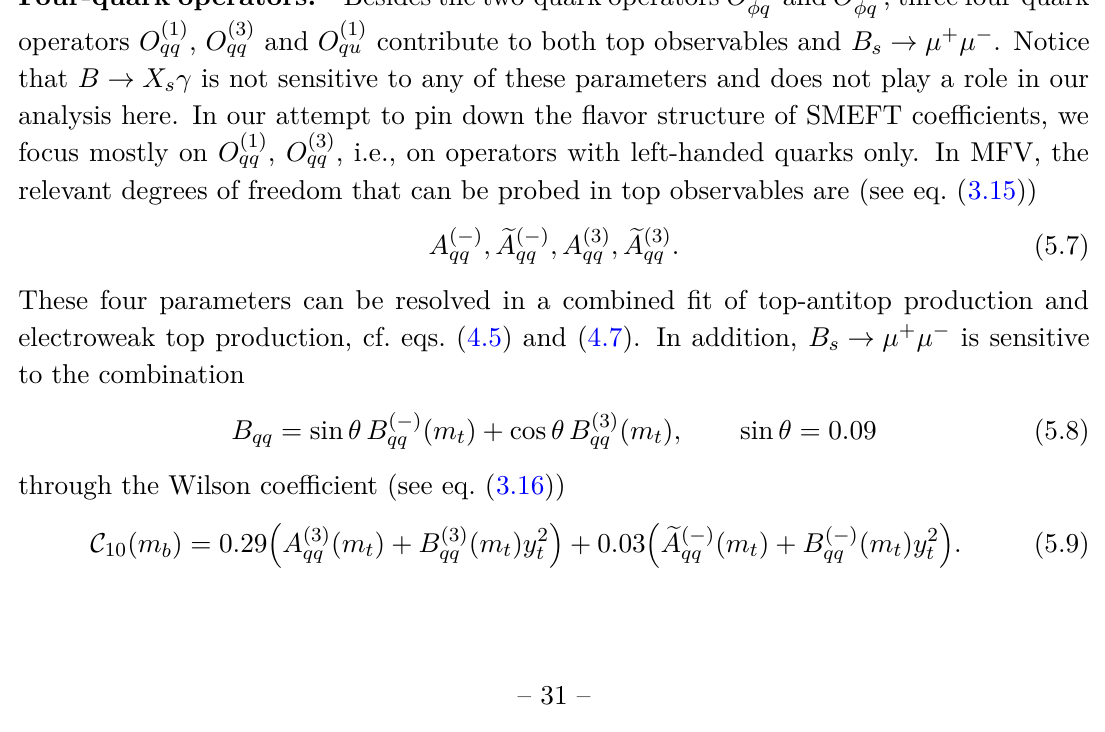
Figure 5 . Impact of electroweak contributions of C ( − ) and t ¯ tW production in MFV. Shown are the ∆ χ 2 = 2 . 30 (solid) and ∆ χ 2 = 5 . 99 (dashed) contours obtained from four-parameter fits of { a ( − ) without (purple) electroweak contributions. B